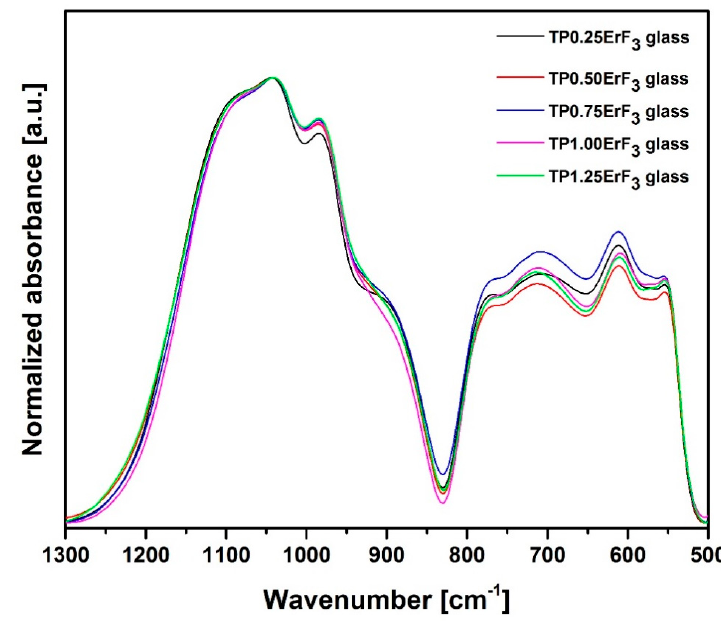
Figure 3. FTIR spectra of precursor glass doped with varying ErF 3 content.